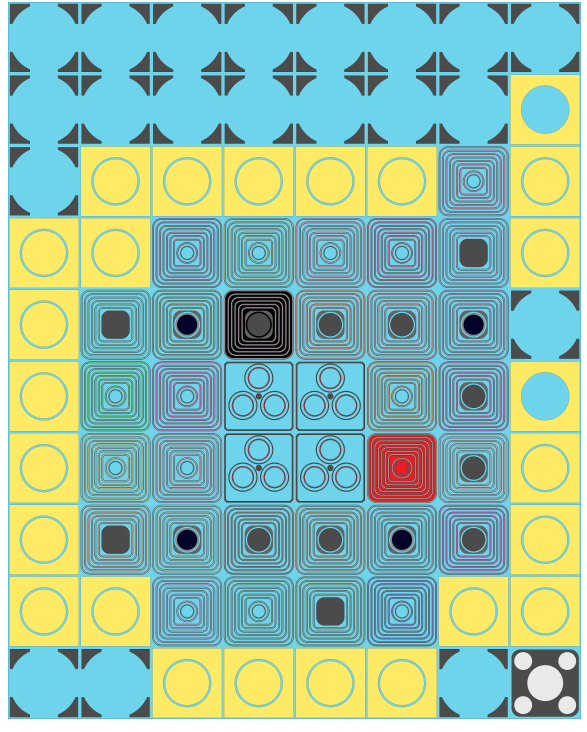
Figure 1. Serpent geometry plot of the opening LVR-15 core configuration of the K216 cycle; two fuel assemblies with initial zero burnup are highlighted (standard 85A710 – red, control 65C666 –